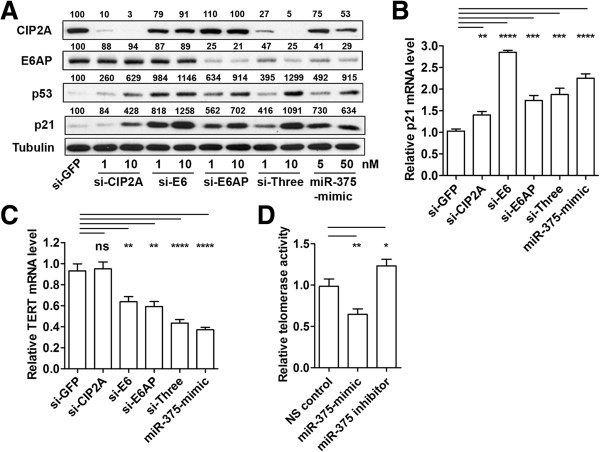
miR-375-mediated repression of HPV16, E6AP, and CIP2A activates the p53-p21 network and suppresses telomerase activity. (A) miR-375 demonstrates upregulation of p53 and p21 comparable to that of the single or combined CIP2A, E6, and E6AP knockdown. CIP2A, E6AP, p53, and p21 protein levels in SiHa cells transfected with siRNA targeting CIP2A, HPV16-E6, and E6AP (si-CIP2A, si-E6, and si-E6AP, respectively) were analyzed by Western blot. 1 nM and 10 nM siRNA concentrations and 5 nM and 50 nM for miR-375-mimic were used for transfection. si-Three is a combination of the three siRNAs indicated above. 10 nM of si-GFP was used as a control. Tubulin expression was used as internal control. (B) The increase in p21 protein levels correlate to its mRNA levels. Relative endogenous p21 mRNA levels transfected with siRNAs or miR-375 were measured using qRT-PCR. (C) miR-375 exerted a similar or stronger reduction in TERT mRNA levels when compared to E6 and E6AP knockdown in SiHa cells. (D) SiHa cells transfected with miR-375-mimic significantly reduced telomerase activity. Relative telomerase activities in SiHa cells transfected with NS control, miR-375-mimic, and miR-375 inhibitor were measured by SYBR real-time PCR TRAP assay. Heat-inactivated telomerase extracts were used to normalize this data. *p < 0.05, **p < 0.01, ***p < 0.001, and ****p < 0.0001. ns, not significant.